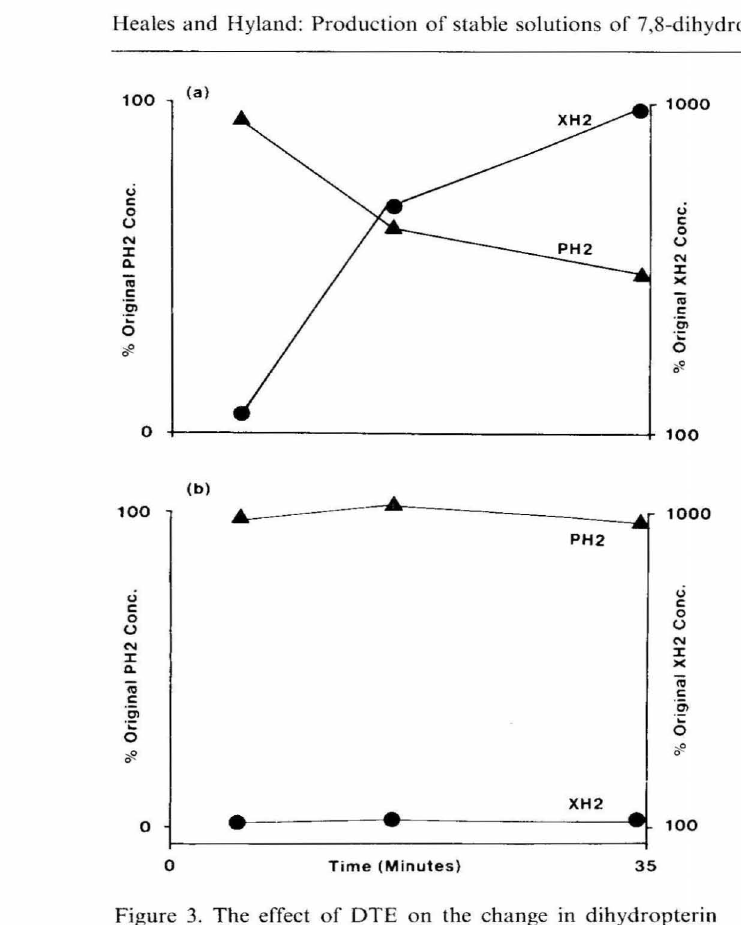
Figure 3. The effect of DTE on the ch<tnge in dihydropterin and dihydroxanthopterin concentrations with time. PH4 (140 ~M) was oxidised by potassium ferricyanide (280 ~M) in 0.1 M phosphate buffer pH 6.8. The qPH2 generated was allowed to rearrange for 30 minutes at room temperature prior to incu bation at 37 "c. (a) = Change in PH2 and XH2 concentration with time. (b) = as for (a). but in the presence of DTE (2